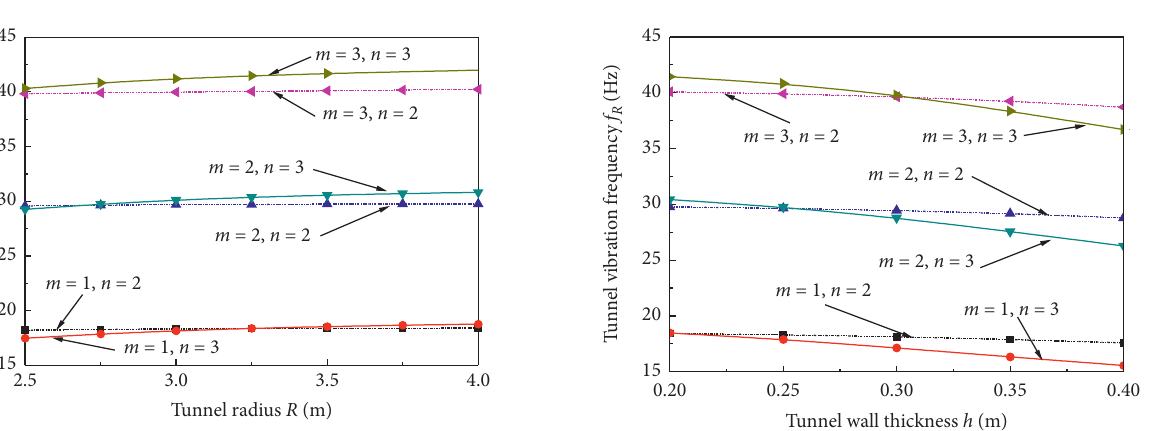
Figure 6: Relationship between natural frequency of the tunnel and tunnel wall thickness for different modes, where η � 1.0 × 10 6 Pa · s.